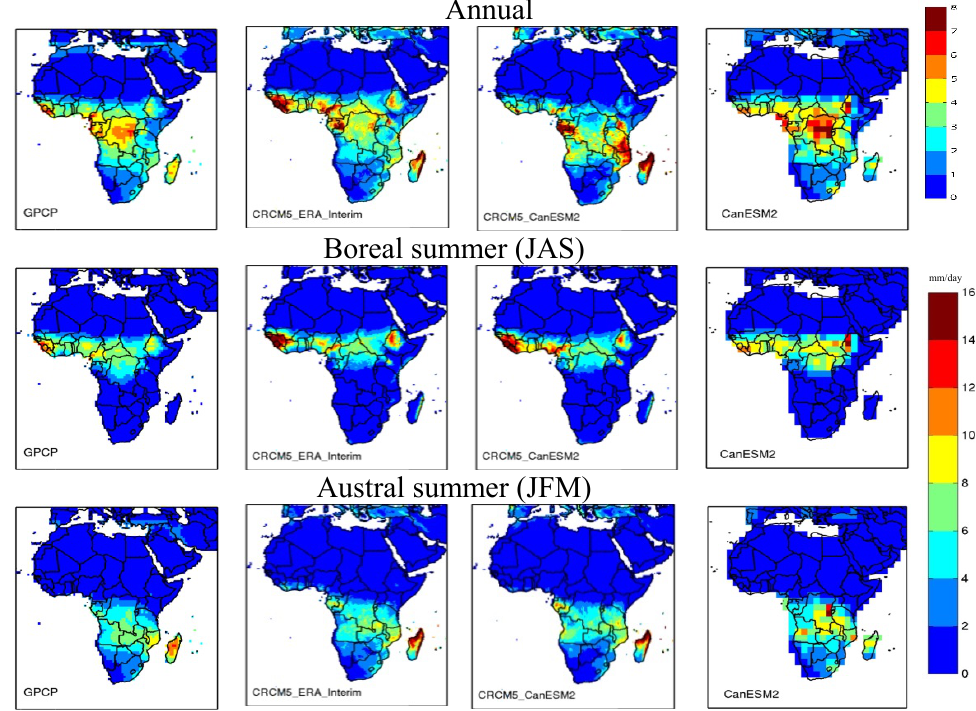
Figure 5. Annual (top row), boreal (middle row) and austral (bottom row) summer mean (1997–2008) precipitation for GPCP (extreme left), CRCM5 driven by ERA-Interim (middle left), CRCM5 driven by CanESM2 (middle right) and CanESM2 (extreme right), for the 1997–2008